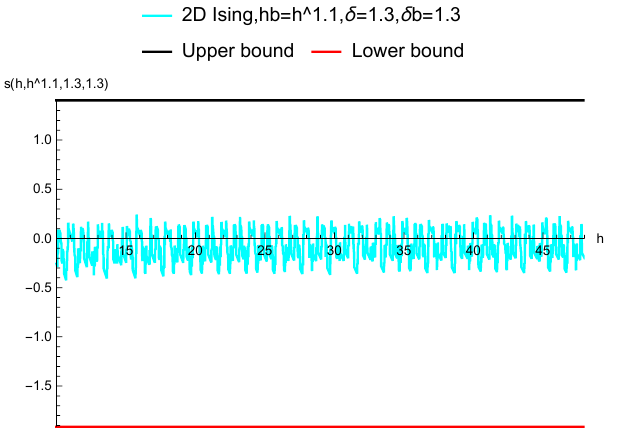
Figure 9 . Verifying the bounds on O (1) correction to entropy ( s ( (cid:14); (cid:22) (cid:14); h; (cid:22) h )) associated with order one window centered at some large h and (cid:22) h , the black line is the upper bound while the red line below is the lower bound. The curvy cyan line is the di(cid:11)erence between the actual number of states lying within the window and leading answer coming from the Cardy formula. Here h and (cid:22) h are of the same order.